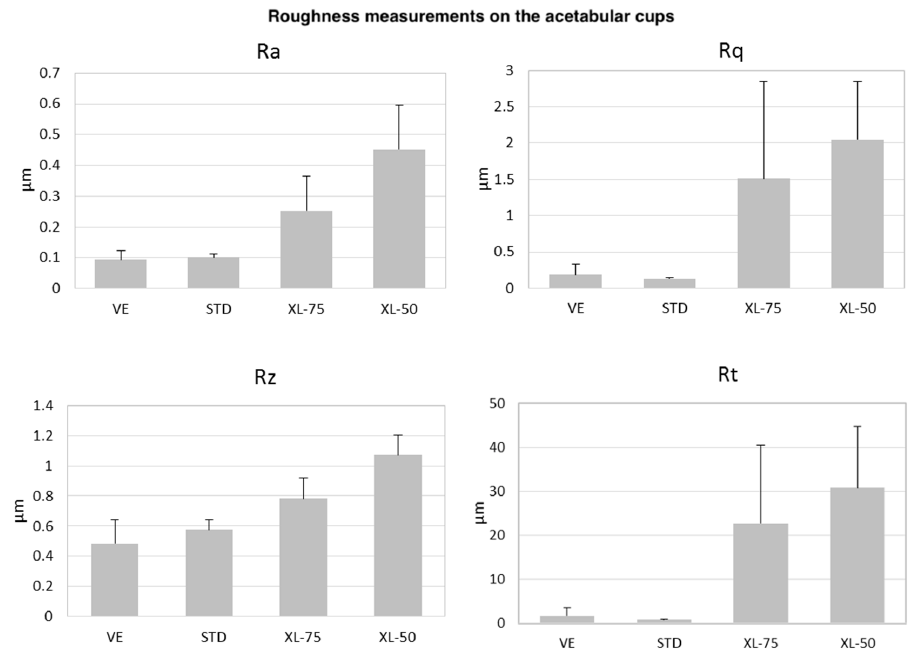
Figure 5. Roughness histograms of the worn surfaces on the mentioned cups. The parameters are Ra, Rq, Rz, and Rt.